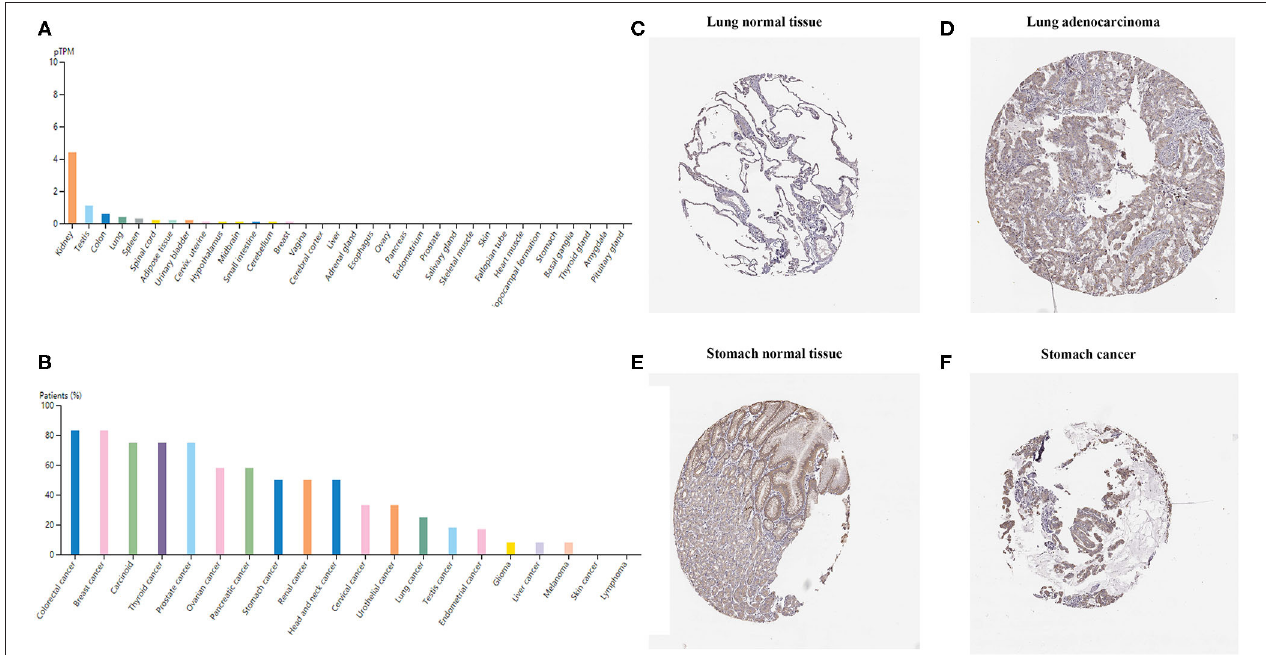
FIGURE 1 | TIM-1 expression profiles in human cancer tissues. (A) TIM-1 expression profiles in normal human tissues. (B) The protein expression profiles of TIM-1 in human cancer tissues. (C–F) Representative IHC images of TIM-1 expression in normal stomach tissues, stomach cancer tissues, normal lung tissues, and lung adenocarcinoma tissues.